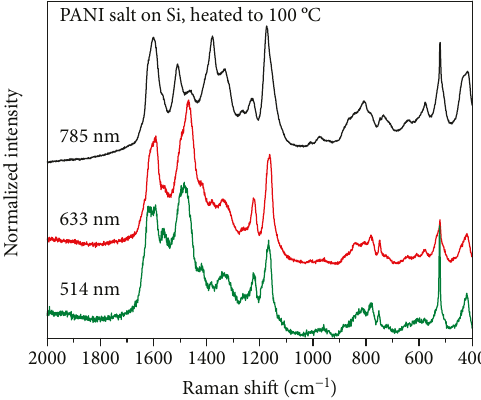
Figure 6: Raman spectra of the PANI fi lm heated at 100 ° C in nitrogen atmosphere, excited with the 514, 633, and 785nm laser